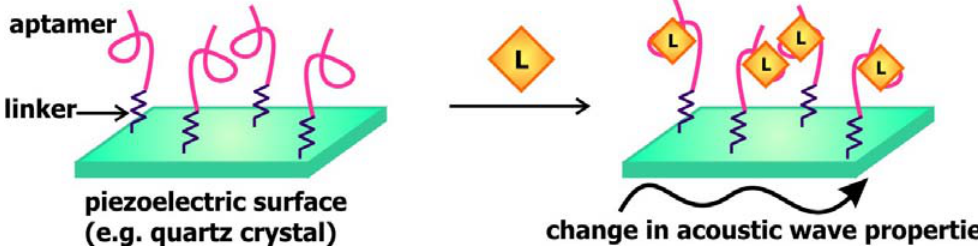
Figure 8. General design and mechanism of acoustic aptamer biosensors